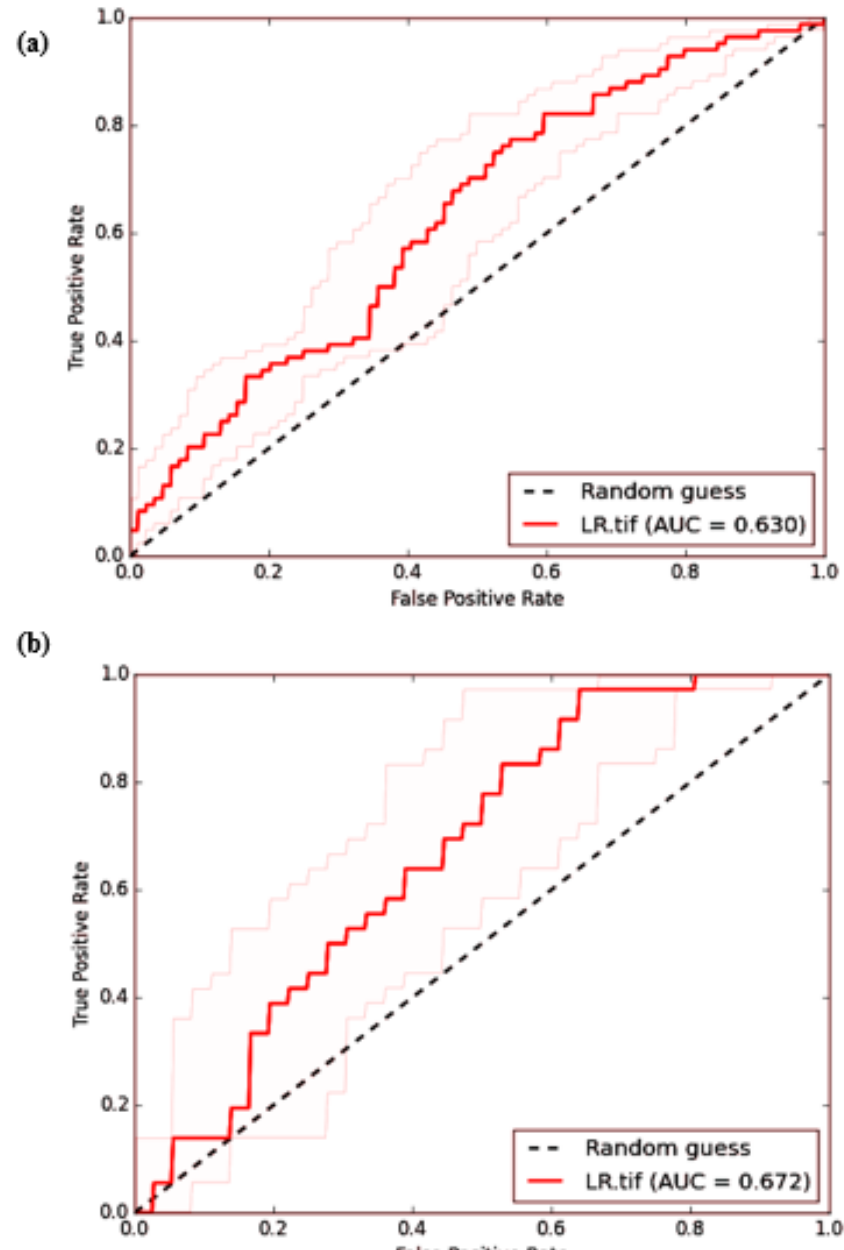
Figure 11. Prediction rate curve for gully erosion susceptibility map using LR in Kakia-Esamburmbur catchment: ( a ) training and ( b ) validation.